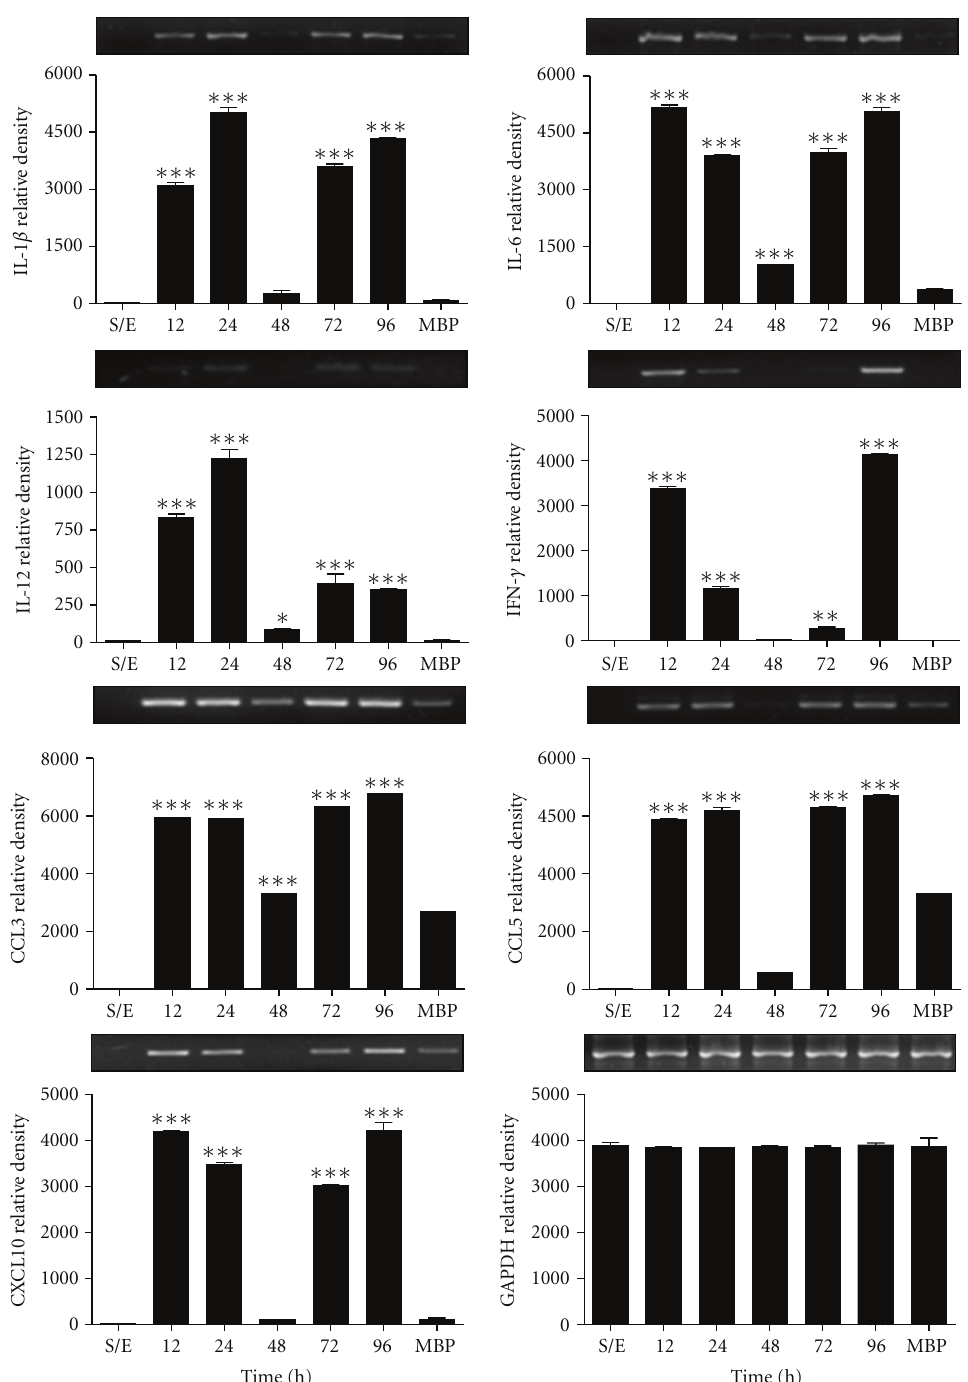
Figure 2: Expression of genes for cytokines and chemokines in PBMC stimulated with rMBP::SSP4. The cells were stimulated with recombinant protein for 12–96 h. The intensities of each band were quantified and plotted from the gels that are on top of each graph corresponding to the expression of genes for cytokines and chemokines. GAPDH was used as control housekeeping gene. ∗ , ∗∗ , ∗∗∗ P < 0 . 05, 0.001, and 0.0001, respectively, versus unstimulated